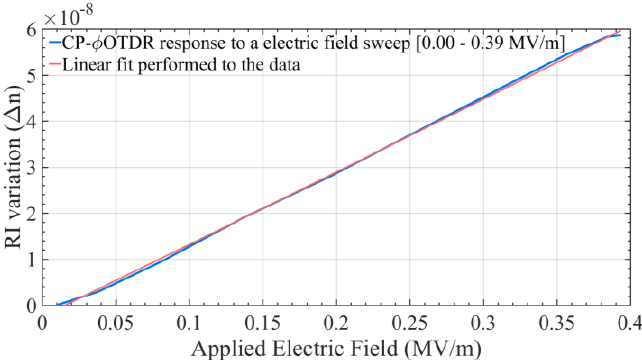
Figure 7. Blue line: RI variation measured by the EO sensor. Signal is averaged over ~1 s (equivalent time for each period). Red line: linear fit performed to the data.